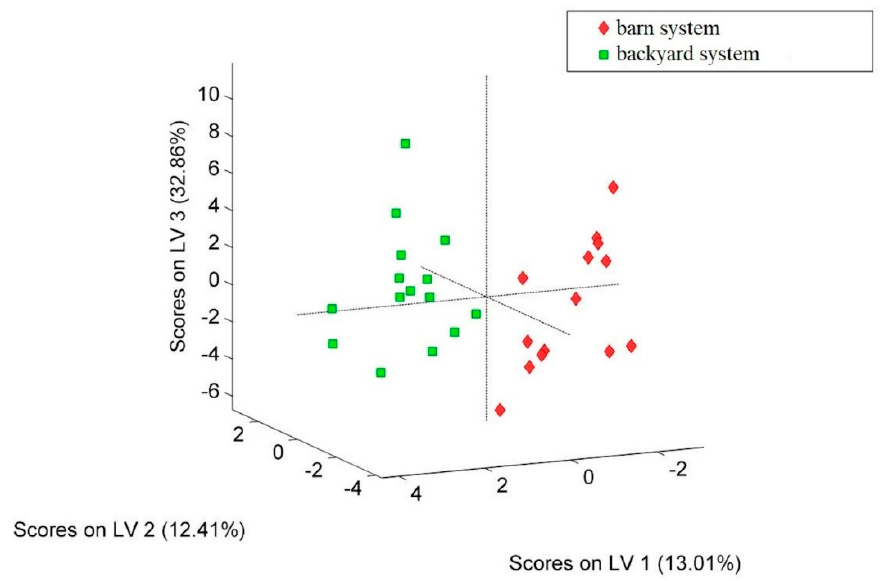
Figure 2. PLS–DA score plot associated with the differentiation of the egg white samples in terms of the hen growing system.